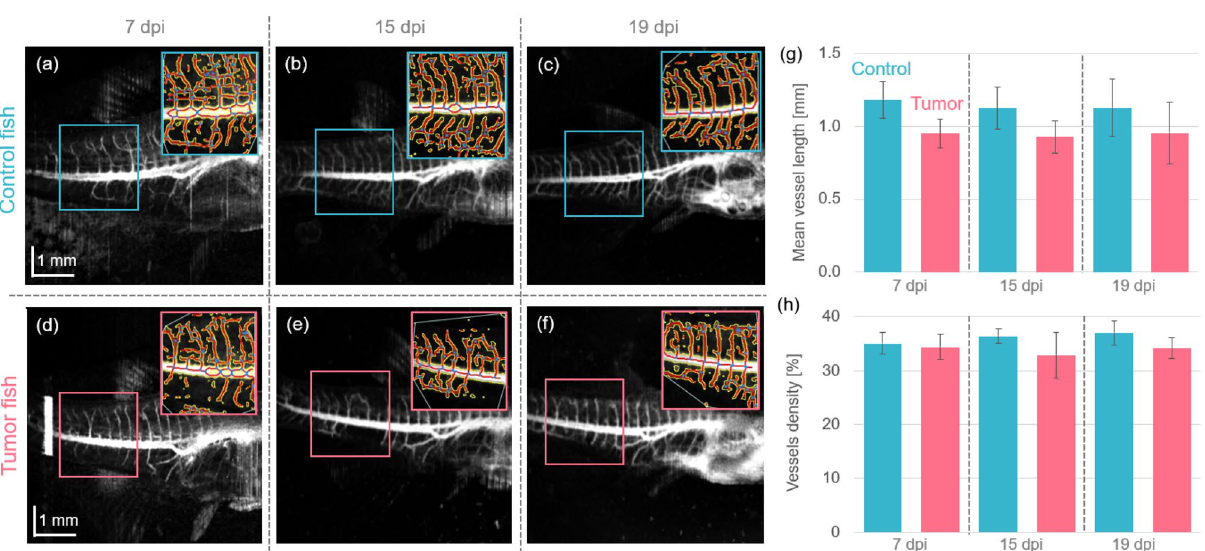
Figure 6. The OCTA data analysis. ( a – c ) OCTA en-face projections in control animals at 7-, 15- and 19-days post injection (dpi). ( d – f ) OCTA en-face projections in tumor injected animals at 7-, 15- and 19-dpi. The analyzed results obtained from AngioTool 37 are included in the upper left corners. ( g ) The mean vessel length in control and tumor injected zebrafish. ( h ) The vessel density in percentage in control and tumor injected